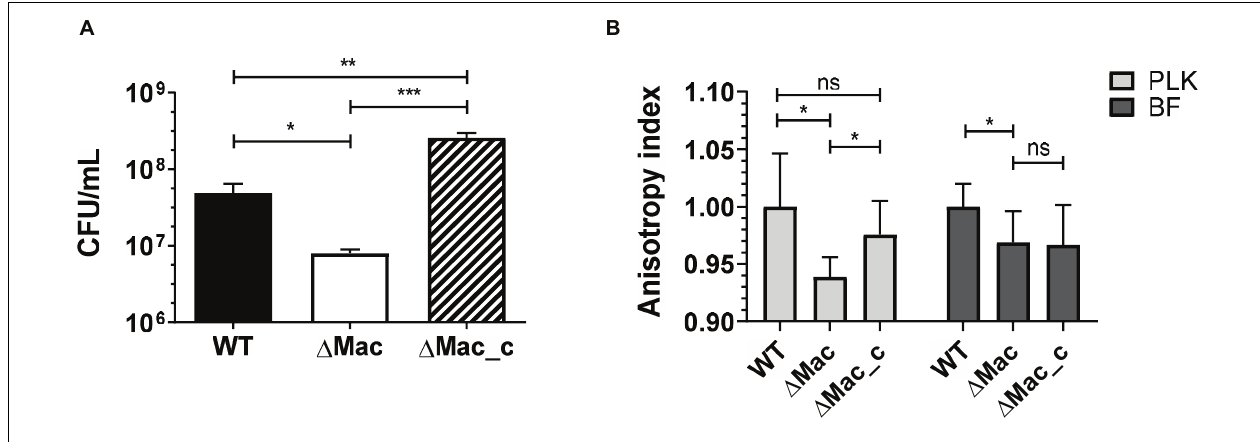
FIGURE 4 | Tolerance to sucrose and membrane fluidity analyses of WT vs. (cid:49) Mac and (cid:49) Mac_c derivative strains of A. baumannii . (A) The 24 h growth measurements in high-osmolarity condition (500 mM sucrose). (B) Fluorescence anisotropy measurements of planktonic (PLK) growth culture (24 h; clear gray) or biofilm (BF) growth culture (48 h; dark gray). Data shown represent mean values ( ± SD) from at least three independent experiments. The data were statistically analyzed using unpaired t -test to calculate p -values (ns, not significant; * p < 0.05; ** p < 0.01; *** p < 0.001). CFU/mL, colony-forming unit per